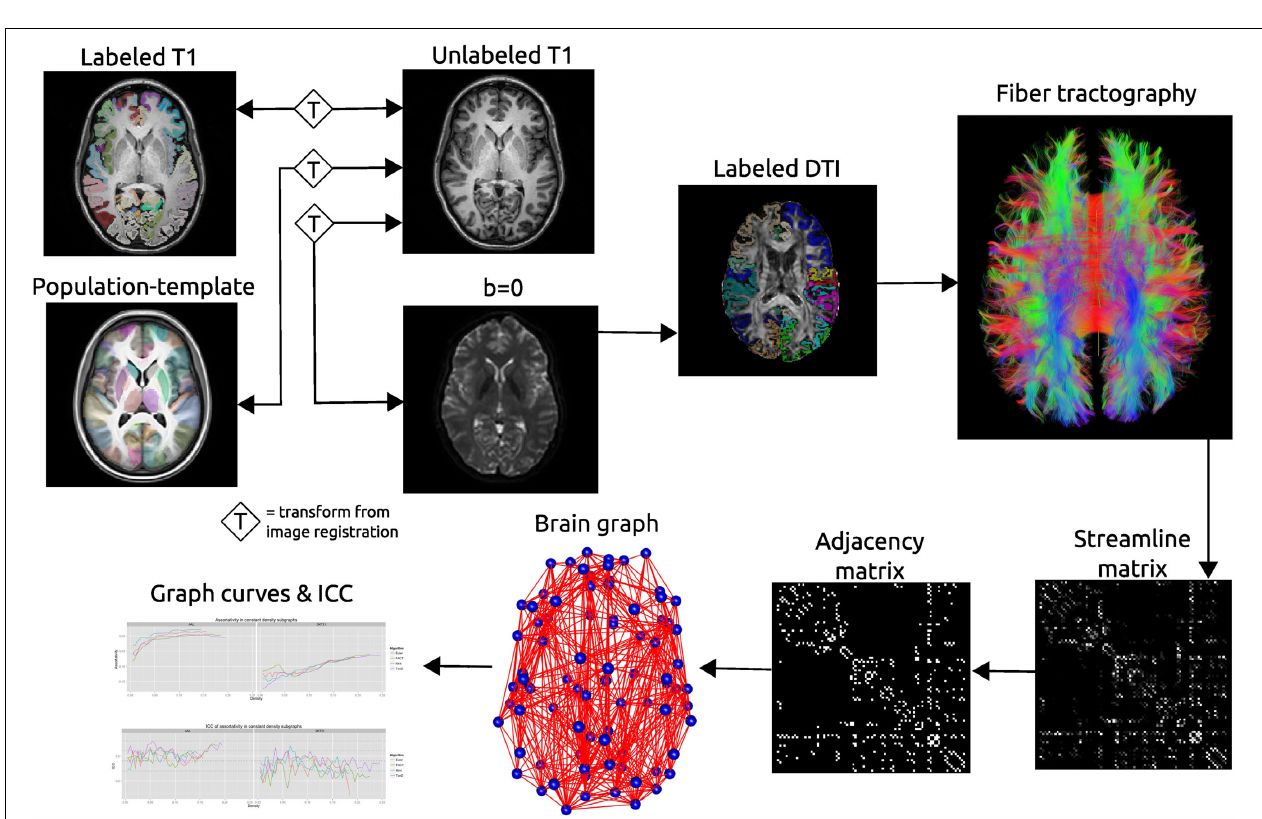
FIGURE 2 | Schematic of the network processing scheme. Image registration is used to find transformations between the T1 image and: the T1 image for that subject’s other time point; the population template; the b = 0 image acquired as part of the DTI acquisition. Labels are transformed into the DTI space where fiber tractography is performed. A matrix is created that